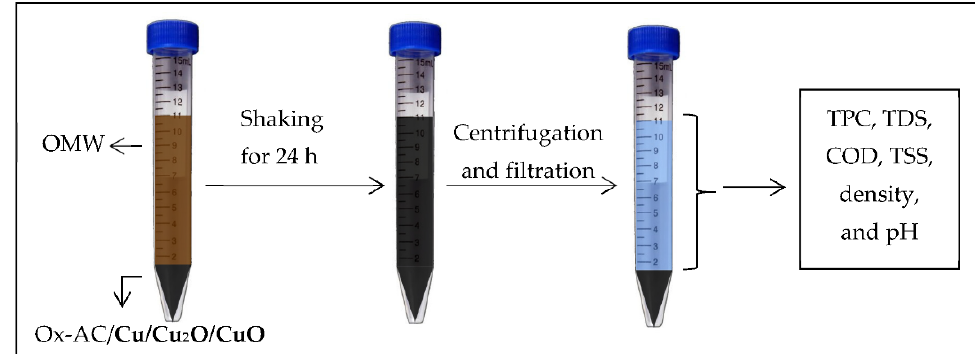
Figure 1. A schematic diagram for the adsorption